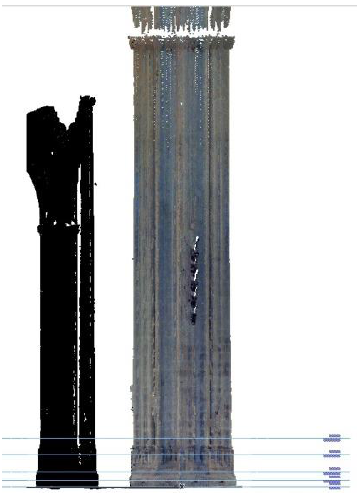
Figure 7. Proportions between the Church of Santiago (left) and the Cathedral of Seville (right)